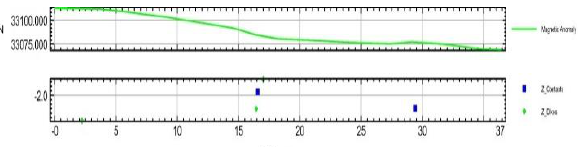
Figure 19: Total magnetic intensity profile for traverse 2 location 2